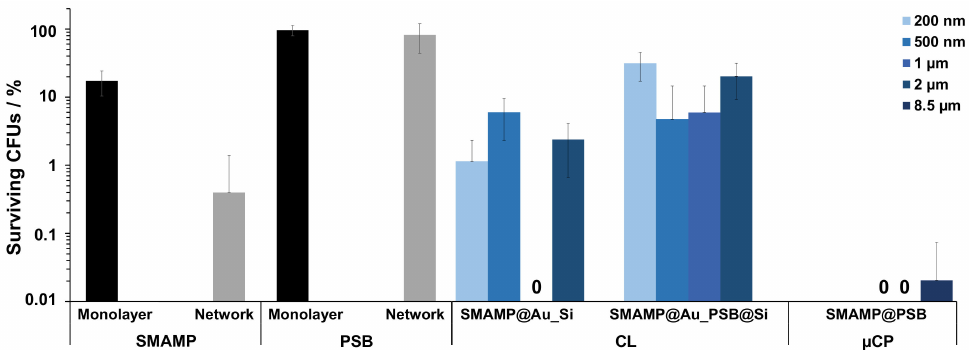
Figure 5. Antimicrobial activity of the di ff erent functionalized surfaces against E . coli bacteria. The normalized percentage of surviving bacteria was plotted for unstructured control surfaces ( SMAMP monolayer and network ; PSB monolayer and network ), structured CL surfaces ( SMAMP@Au_Si and SMAMP@Au_PSB@Si with 200 nm, 500 nm, 1 µ m and 2 µ m spacing, respectively), and